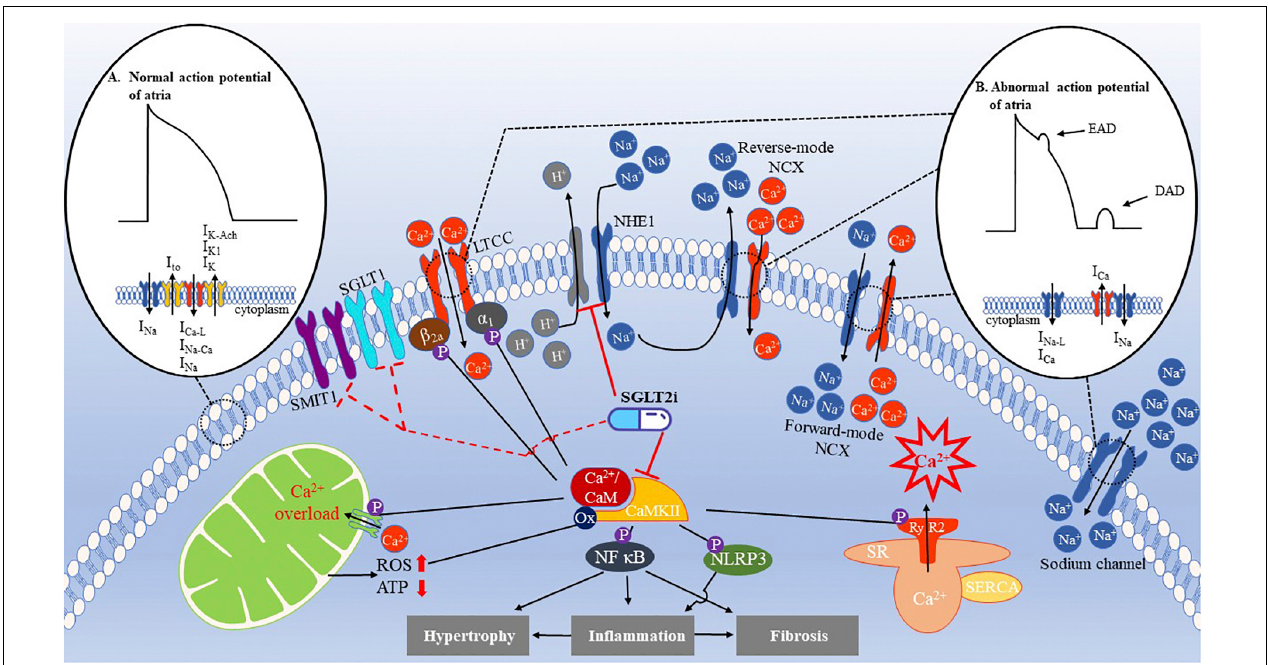
FIGURE 1 | Ion disorder and mitochondrial dysfunction in AF and cardioprotective effects of SGLT2i. (A) The normal action potential (AP) of atria is initiated by the rapid influx of Na + current (I Na ) to form an upstroke AP. Subsequently, transient outward current (I to ) achieves rapid repolarization, followed by inward L-type Ca 2